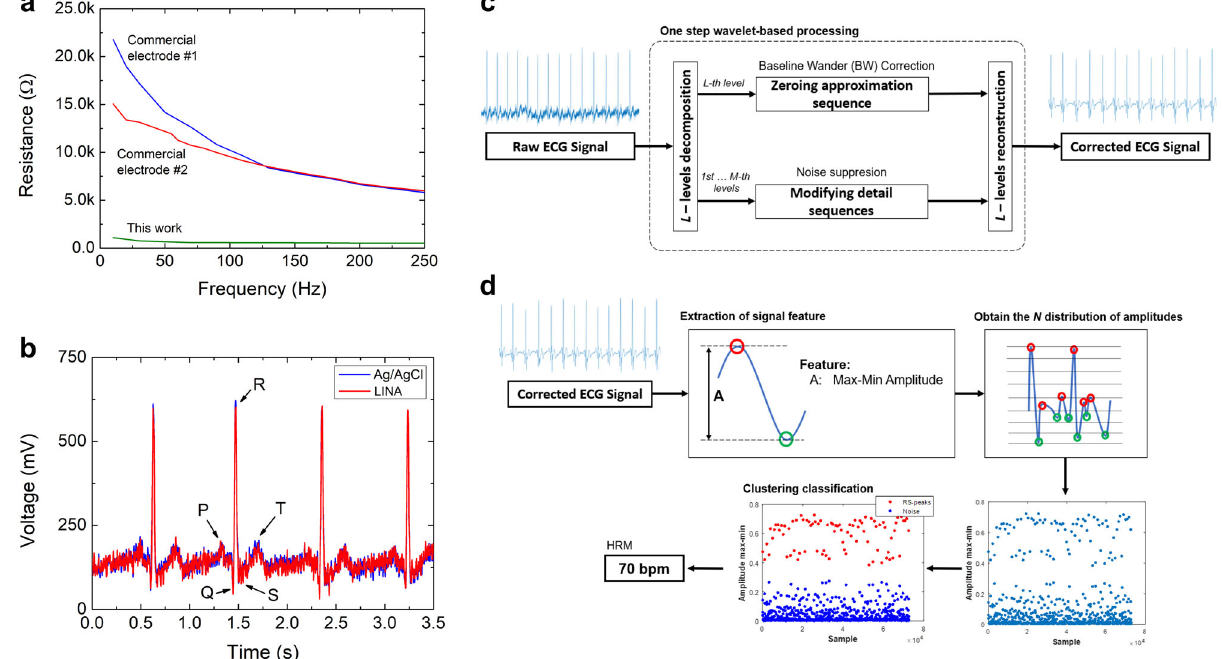
Fig. 2 Electrocardiography recording and processing methods. a Comparison of the skin – electrode contact resistance as a function of the frequency for two commercial electrodes (Ambu ® BlueSensor VL and Biopac EL503, respectively) and the LINA electrode. b ECG recordings carried out simultaneously with the LINA electrodes (in red) and the Ag/AgCl commercial electrodes (in blue). c One step wavelet- preprocessing method for the baseline wandering and noise correction. d Clustering-based method for the heart rate monitoring based on the max – min